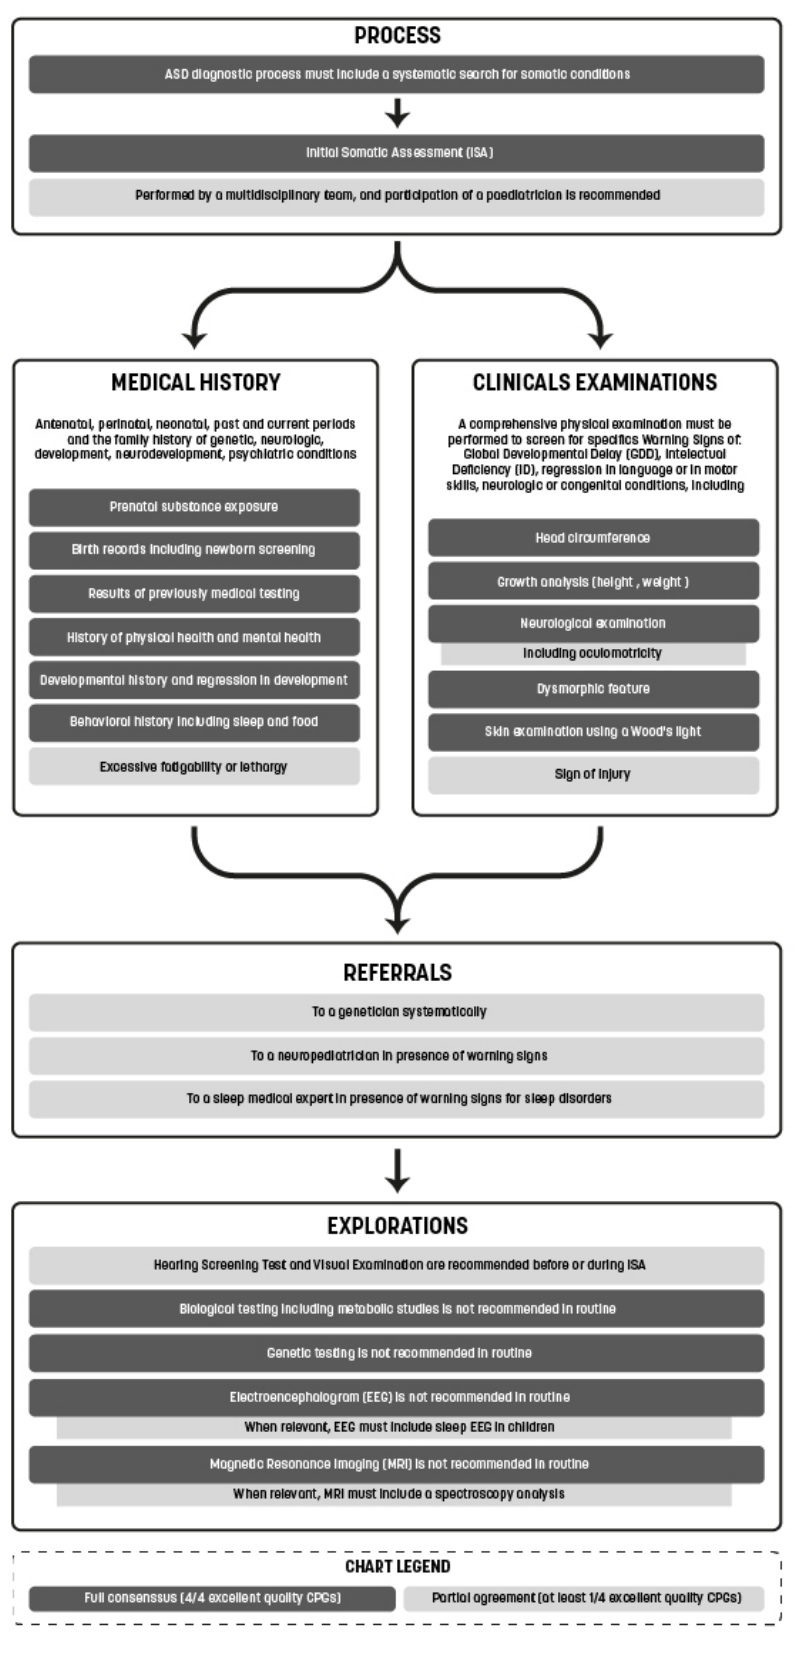
Figure 3. International meta-guidelines for initial somatic assessment (ISA) of ASD.